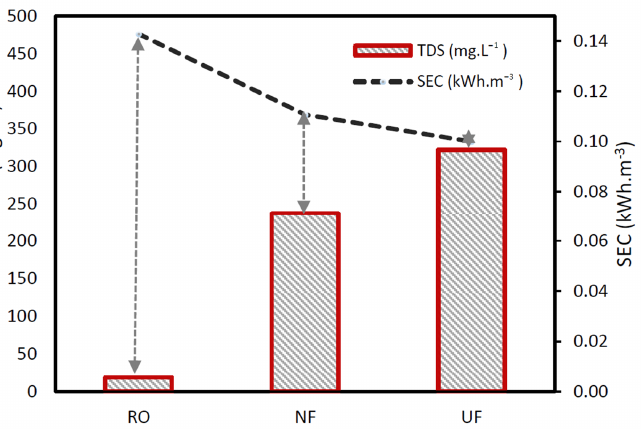
Figure 5. Comparison of membranes systems specific energy consumption concerning the permeate total dissolved solids (TDS) at a fixed permeate flux of 30 L.m −2 h −1 and recovery of 75%. Table 5. Characteristics of UF/NF/RO effluent average water quality with reuse criteria for wastewater in different applications. Irrigation Parameter [23,24]